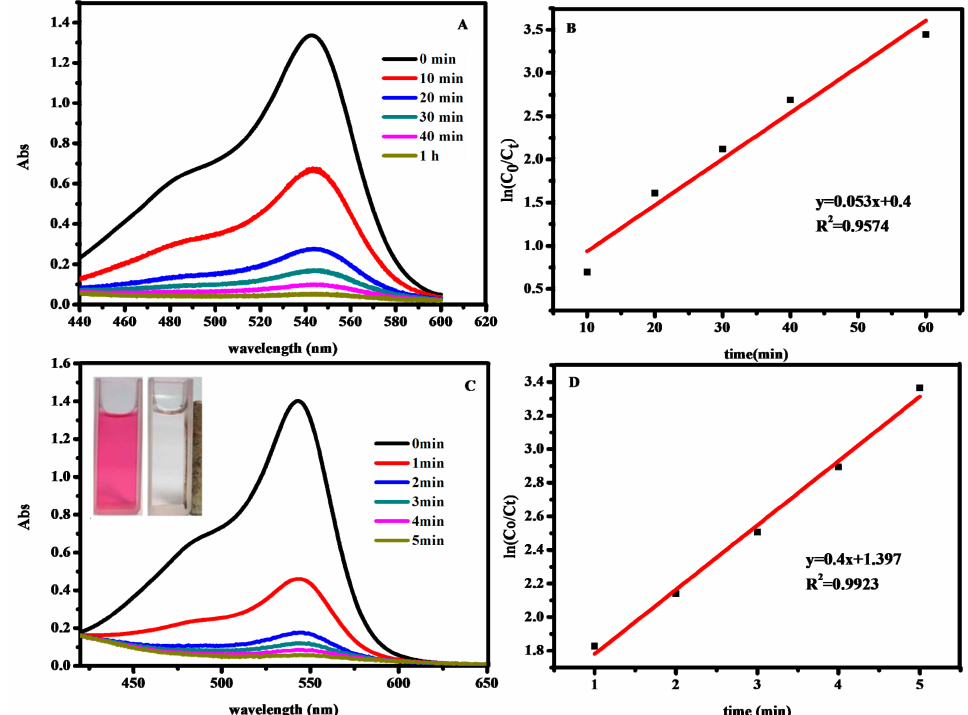
Figure 6. Time-dependent UV-Vis spectral changes of basic fuchsin ( A ); ln (C 0 /C t ) and time diagram of H 2 O 2 degradation of basic fuchsin ( B ); Time-dependent UV-Vis spectral changes of basic fuchsin with Fe 3 O 4 @SiO 2 MNPs(C); ln (C 0 /C t ) and time diagram of H 2 O 2 degradation of basic fuchsin with Fe 3 O 4 @SiO 2 MNPs(D). The inset of UV-Vis spectra shows the color of dye solution before (right) and after (left)